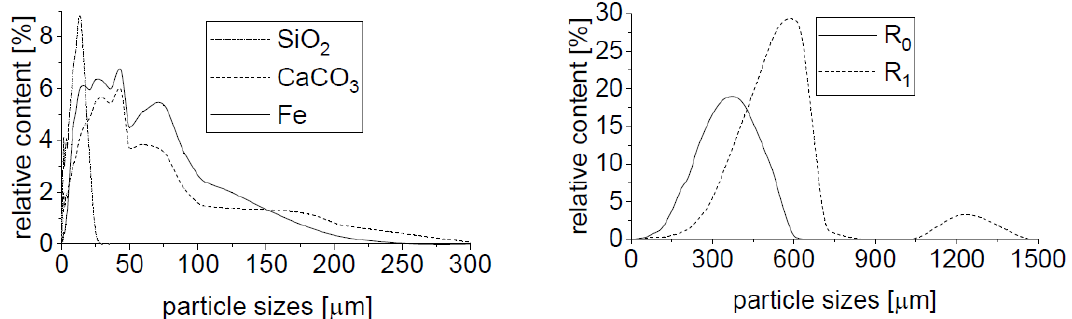
Figure 2. Particle size distribution of used fillers obtained from HELOS (H2568) & RODOS — laser analysis. Figure taken from previous work [33]. Reprinted by permission from Springer Nature Cus-